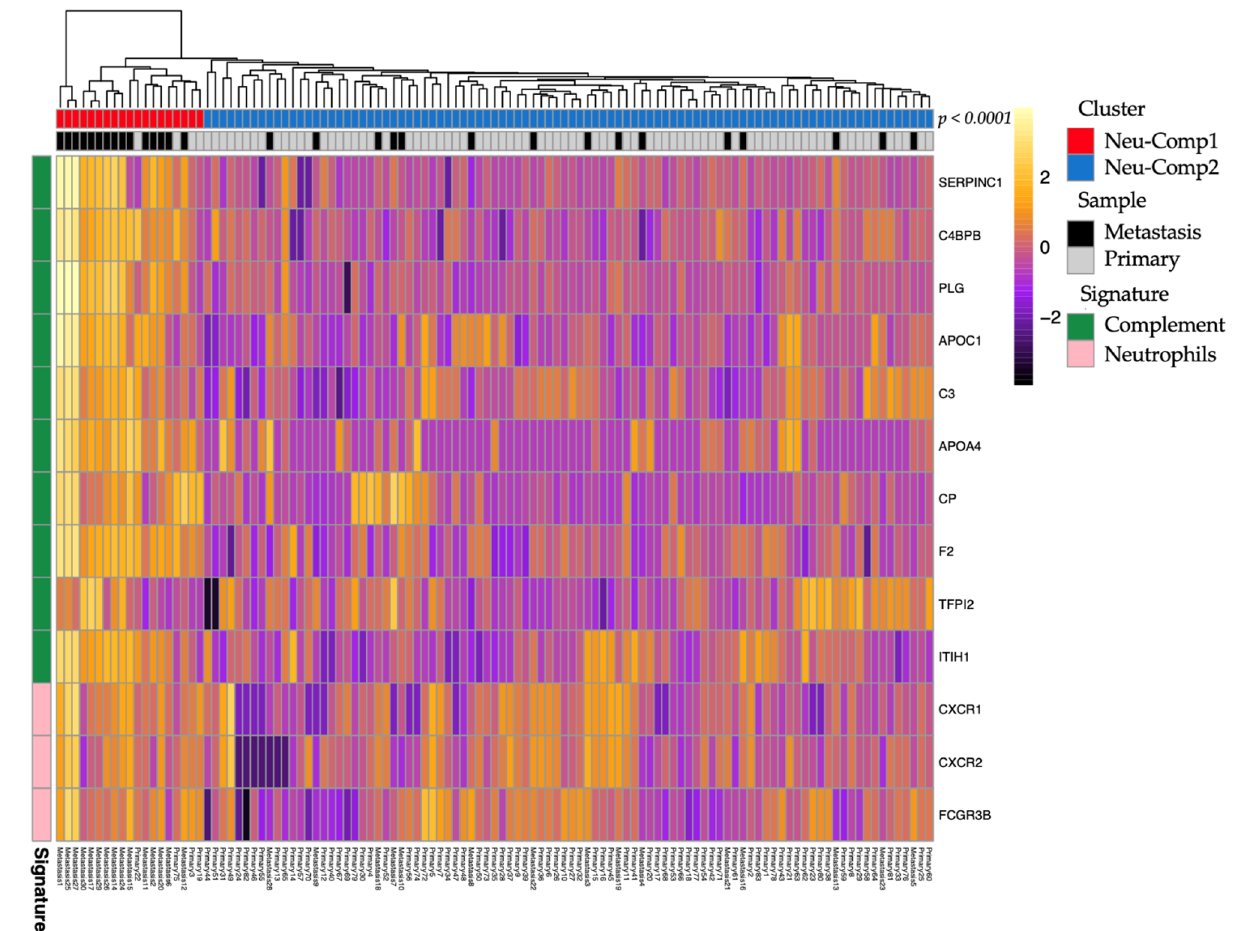
Figure 5. Unsupervised clustering of pNETs according to neutrophils and complement pathway gene expression signatures. Note that metastatic pNET cluster together as compared to localized pNETs ( p < 0.0001).